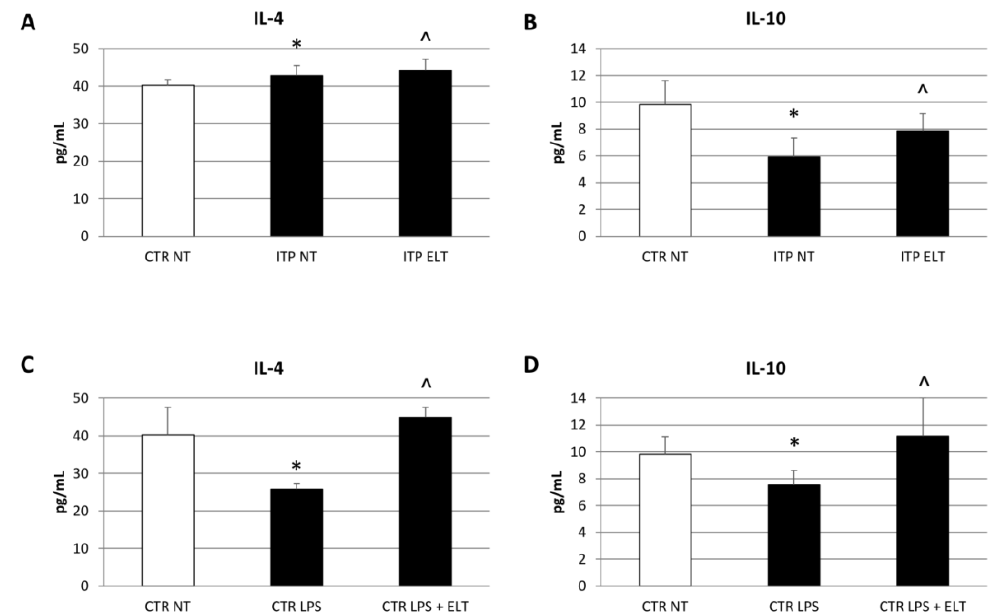
Figure 4. Effect of ELT on IL-4 and IL-10 release. ( A , B ) IL-4 and IL-10 concentrations (pg/mL) in ITP macrophages compared with CTR NT macrophages, determined by Enzyme-linked Immunosorbent assay (ELISA Assay), after treatment with ELT (6 µ M). Histogram shows IL-4 ( A ) and IL-10 ( B ) concentrations as the mean ± S.D. of independent experiments on each individual sample. The cytokines concentration was determined on a standard concentration curve according to the manufacturer’s instructions. A t -test wasused for statistical analysis. * indicates p ≤ 0.05 compared to CTR NT, ˆ indicates p ≤ 0.05 compared ITP NT. ( C , D ) IL-4 and IL-10 concentrations (pg/mL) in ITP macrophages compared with CTR macrophages, determined by ELISA Assay, after treatment with LPS (500 nM) and LPS combined with ELT (6 µ M). Histogram shows IL-4 ( C ) and IL-10 ( D ) concentrations as the mean ± S.D. of independent experiments on each individual sample. The cytokines concentration was determined on a standard concentration curve according to the manufacturer’s instructions. A t -test was used for statistical analysis. * indicates p ≤ 0.05 compared to CTR NT, ˆ indicates p ≤ 0.05 compared to CTR LPS.